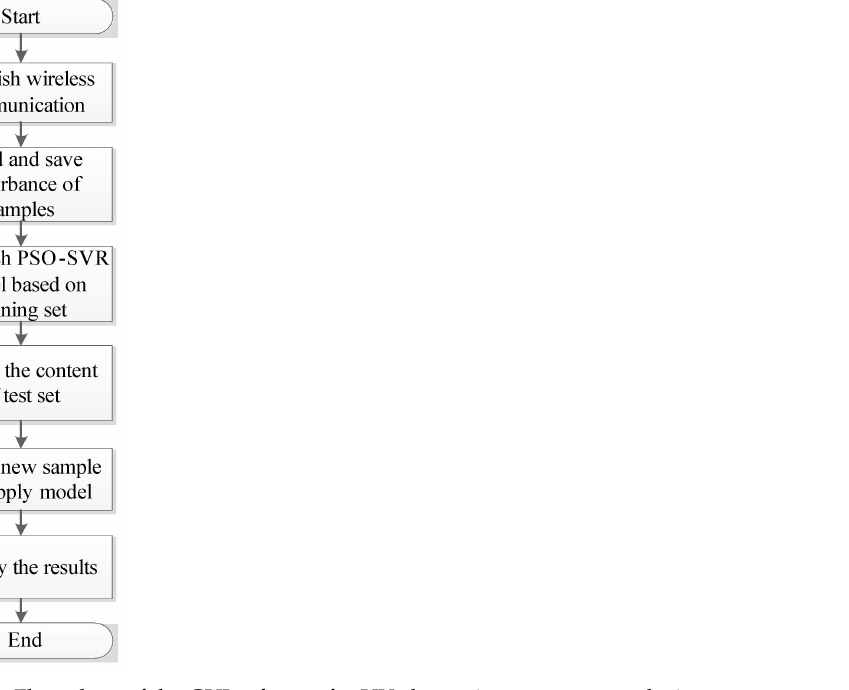
Figure 2. Flow chart of the GUI software for UV absorption spectrum analysis.